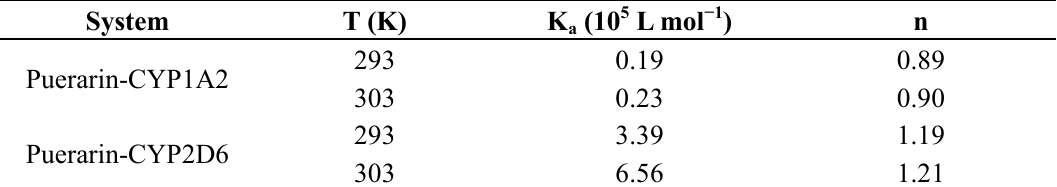
and numbers of binding sites n. a